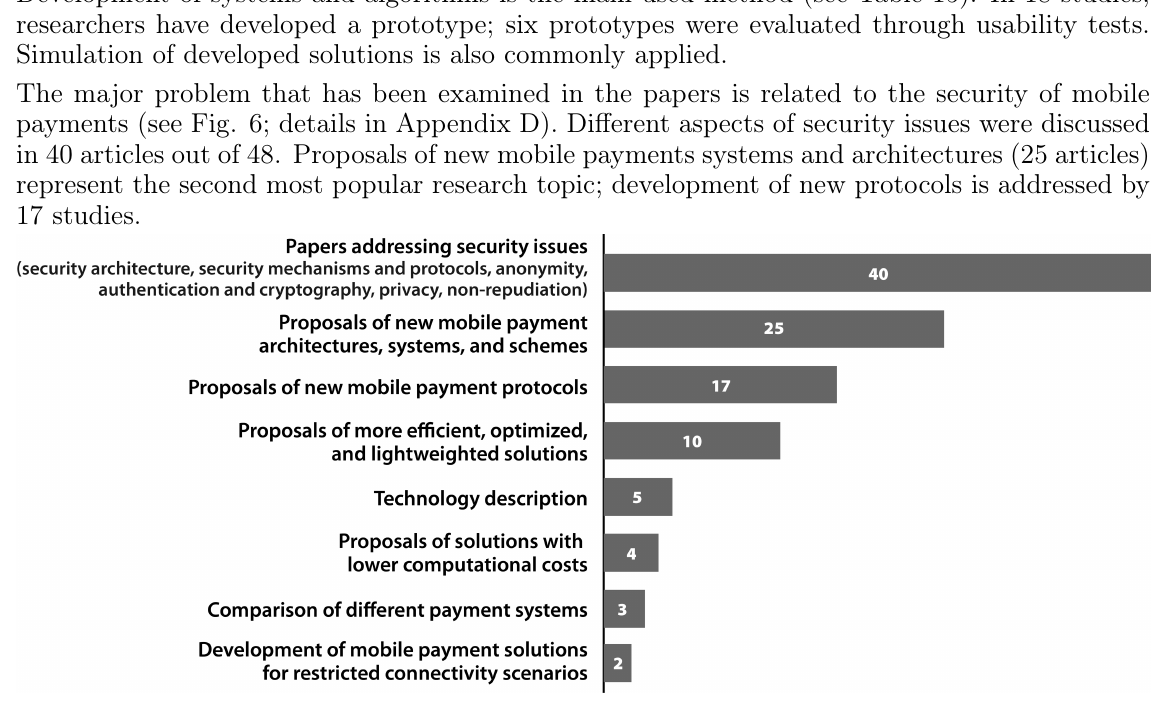
Fig. 6. Classification of papers on technology by